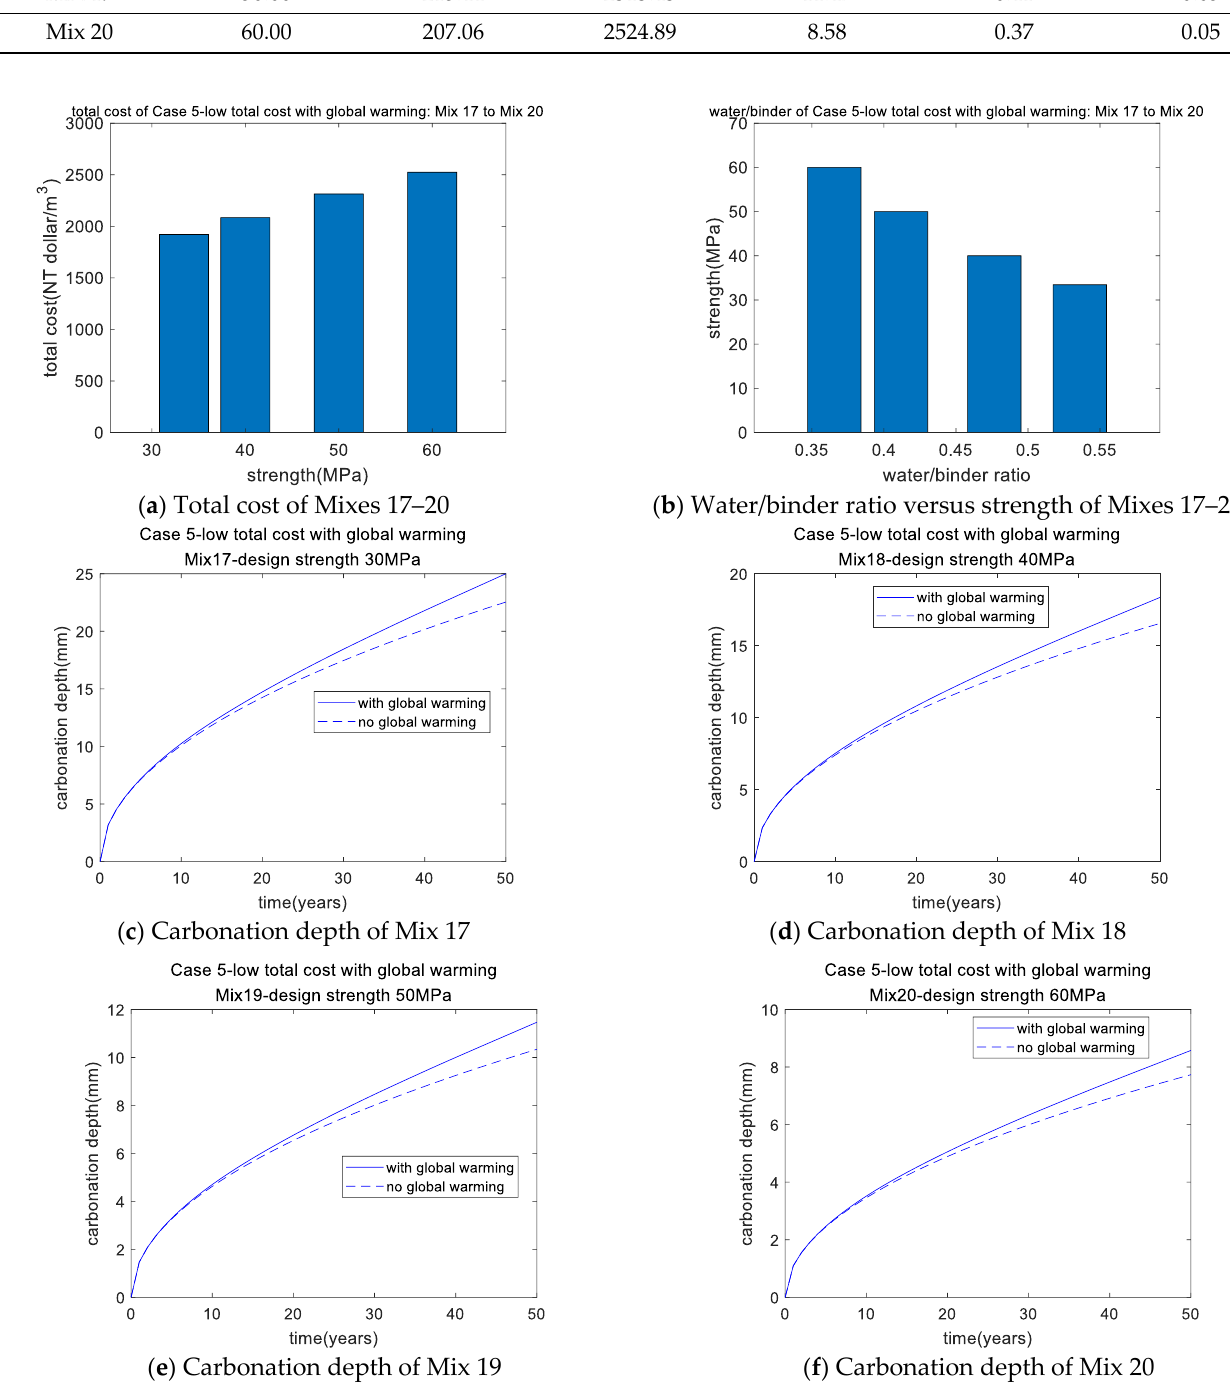
Figure 7. Performance of Case 5: Mixes 17 – 20 (low total cost with global warming).